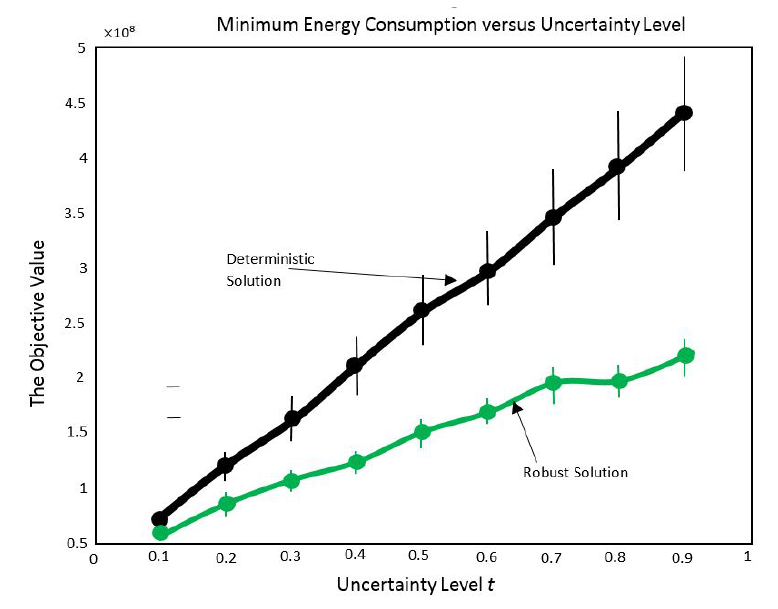
Figure 18. Mean and standard deviation of objective value for deterministic and robust solutions in minimum energy consumption problem for different uncertainty levels